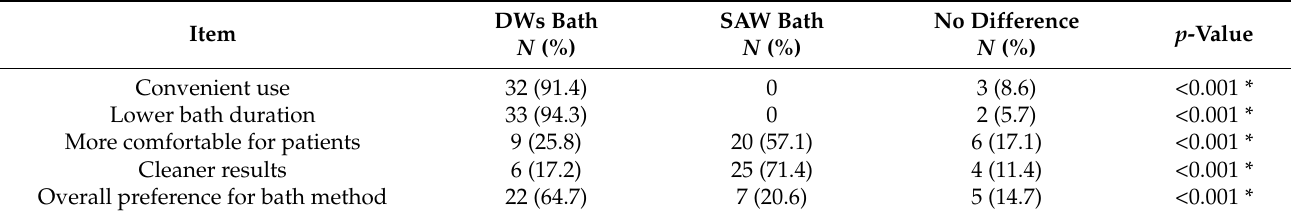
Table 3. Staff satisfaction related to the bed-bathing methods ( n = 35).